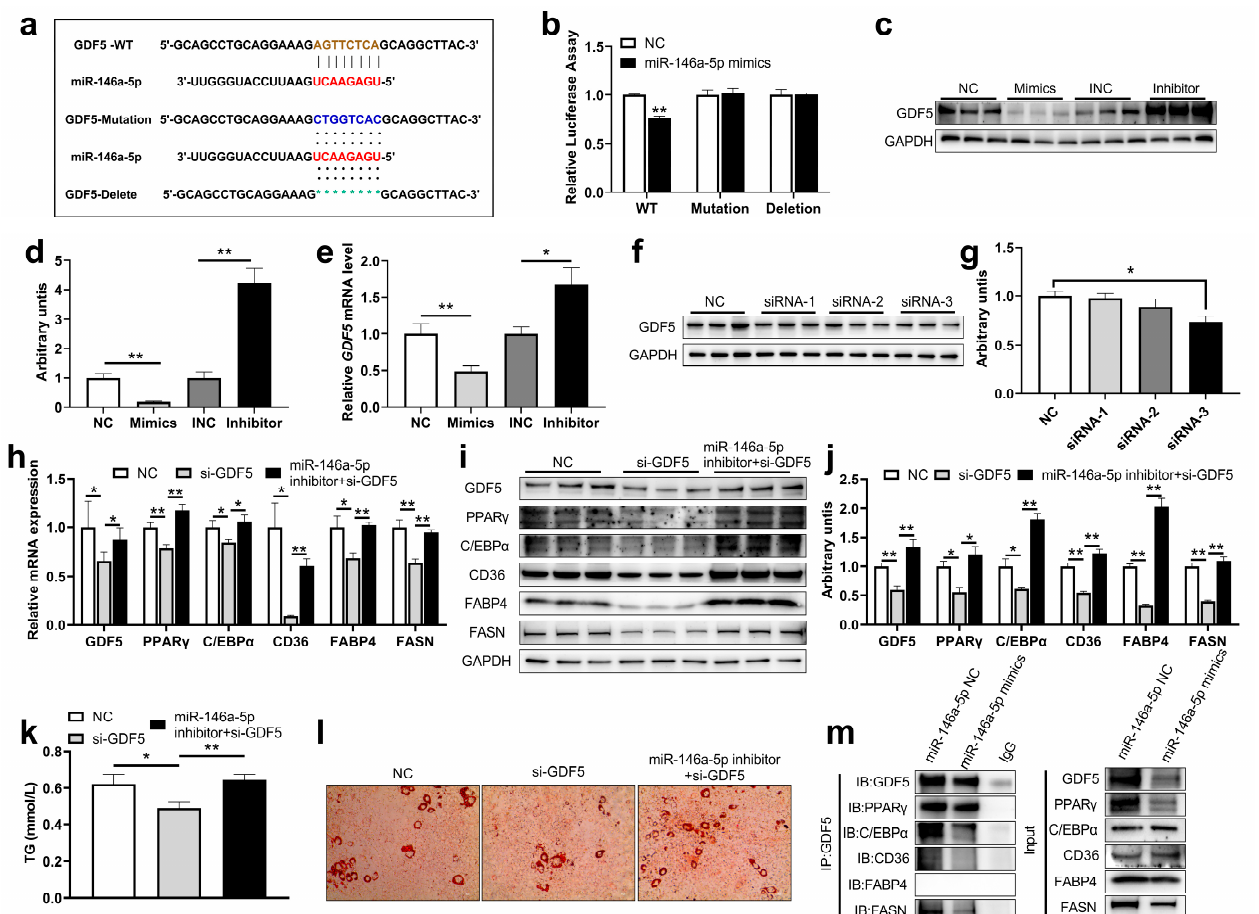
Figure 4. miR-146a-5p regulated PPAR γ signaling pathway by targeting GDF5. ( a ) miR-146a-5p has a target interaction with the 3 ′ UTR of GDF5. ( b ) Statistical chart of miR-146a-5p and GDF5 dual luciferase validation fluorescence values (n = 8). ( c , d ) After transfections of miR-146a-5p mimics (Mimics) and miR-146a-5p inhibitor (Inhibitor), GDF5 was detected by Western Blot in mature 3T3-L1 cells (n = 6). ( e ) After transfections of mimics and inhibitor, GDF5 gene expression was detected by real-time quantitative PCR (n = 6). ( f , g ) 3T3-L1 cells were transfected with GDF5 siRNA for 48 h, and GDF5 was detected by Western Blot (n = 6). ( h ) After transfection (NC, GDF5 siRNA, miR-146a-5p inhibitor + GDF5 siRNA), GDF5, PPAR γ C/EBP α , CD36, FABP4 and FASN expressions were detected by real-time quantitative PCR (n = 6). ( i , j ) After transfection (NC, GDF5 siRNA, miR-146a-5p inhibitor + GDF5 siRNA), proteins GDF5, PPAR γ C/EBP α , CD36, FABP4 and FASN were de- tected by Western Blot (n = 6). ( k ) After transfection (NC, GDF5 siRNA, miR-146a-5p inhibitor + GDF5 siRNA), TG content was assayed (n = 6). ( l ) After transfection (NC, GDF5 siRNA, miR-146a- 5p inhibitor + GDF5 siRNA), oil red O staining was performed (scale bar = 50 μ m). ( k ) Oil Red O readings (n = 6). ( m ) Immunoprecipitation assay revealed enrichment of PPAR γ C/EBP α , CD36, FABP4, and FASN when introduced with GDF5. Values are presented as means ± SEM, * p < 0.05, and ** p < 0.01, according to the non-paired Student’s t-test or one-way ANOVA between individual groups.